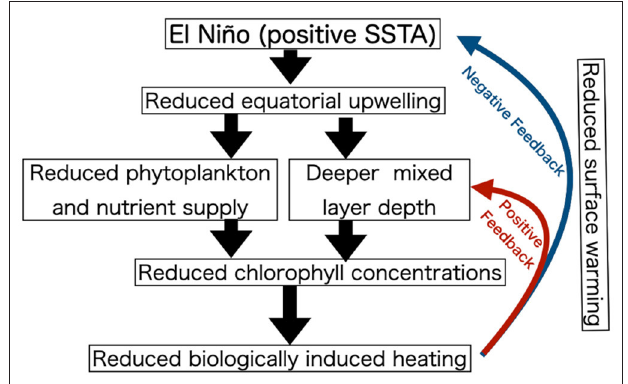
FIGURE 1 | Schematic image of a possible impact of interannual variation of chlorophyll on